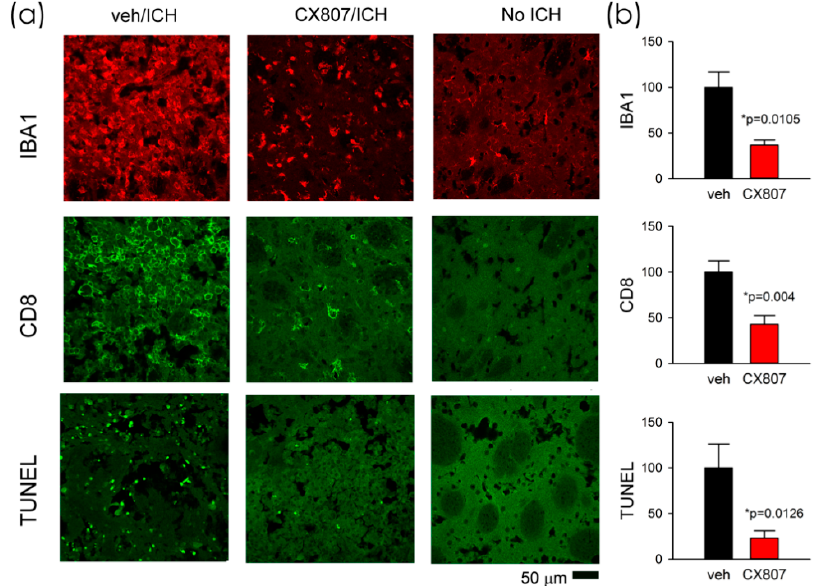
Figure 5. CX807 mitigated IBA1 and CD8 immunoreactivity as well as TUNEL in the ICH brain. ( a ) Representing photomicrographs were taken from the perilesioned area of ICH animals receiving veh (veh / ICH) or CX807 (CX807 / ICH). ICH increased TUNEL, IBA1, and CD8 fluorescence, which were mitigated by CX807. No TUNEL was found in the contralateral side striatum (No ICH). ( b ) TUNEL, IBA1, and CD8 activities were averaged from 6 regions (1267 × 1267 µ m) of two adjacent brain slices at the level of anterior commissure from each brain. CX807 significantly reduced TUNEL, IBA1, and CD8 optical density. Data are represented as mean +/ − SEM. * p values were calculated using a t-test.